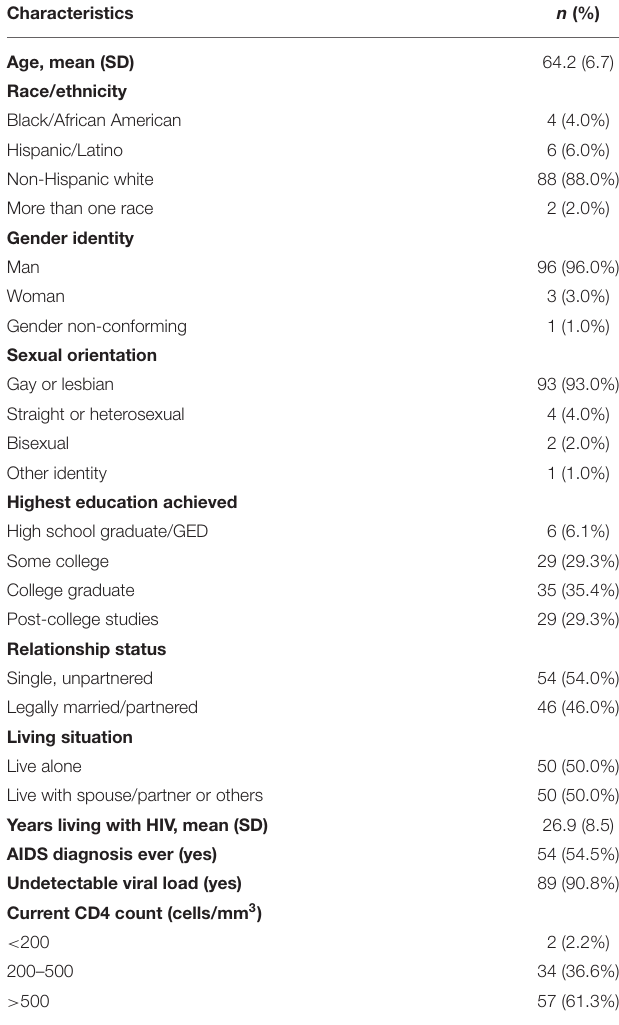
TABLE 1 | Participant demographic and HIV characteristics ( N =